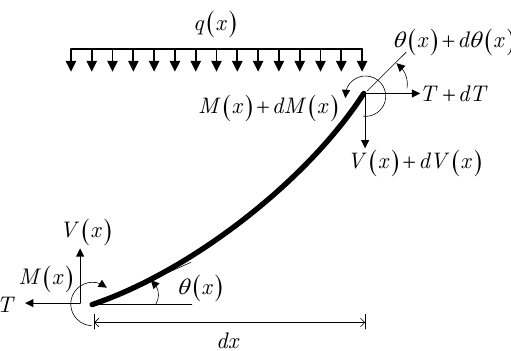
Appl. Sci. 2019 , 9 , x FOR PEER REVIEW Figure 4. Deflected infinitesimal element of a Euler-Bernoulli beam. Figure 4. Deflected infinitesimal element of a Euler-Bernoulli beam.